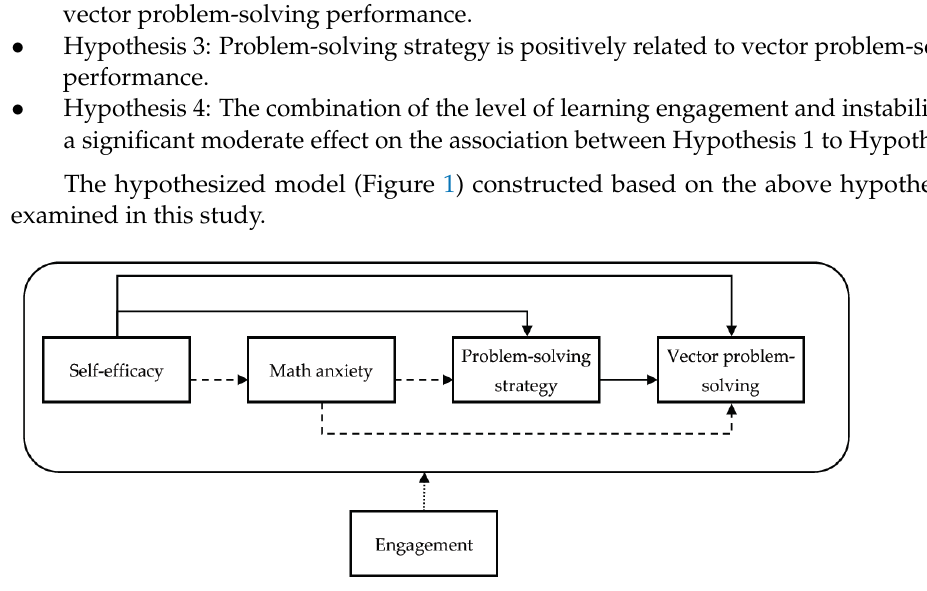
Figure 1. Hypothesized model of the current study. Solid lines assume a positive association, dashed lines a negative association, and dotted lines a moderating effect.